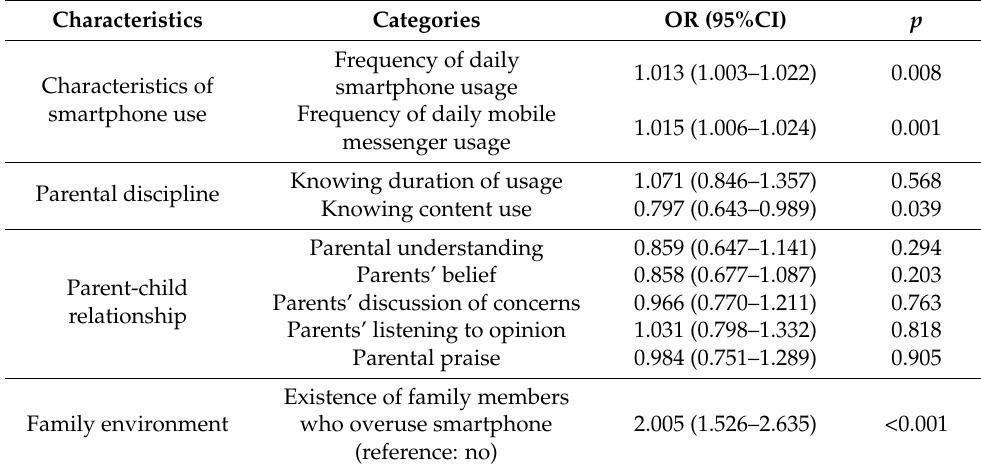
Table 3. Factors of problematic smartphone use among male adolescents ( n =